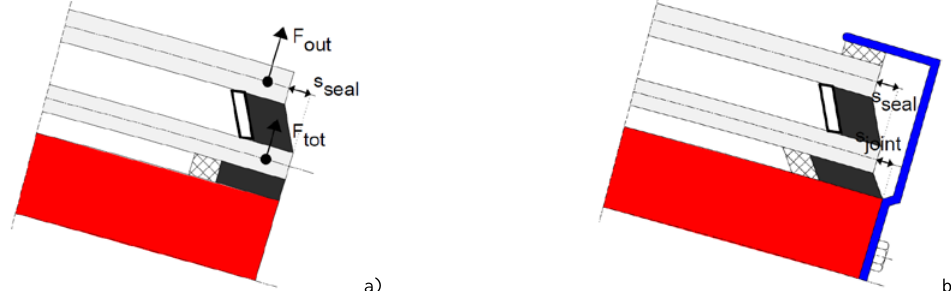
Fig. 8 Deformed joints for system where adhesive is applied a) after frame and IG unit has been cold bent b) on flat assembly which is then cold bent and equipped with load-bearing mechanical devices to retain the IG